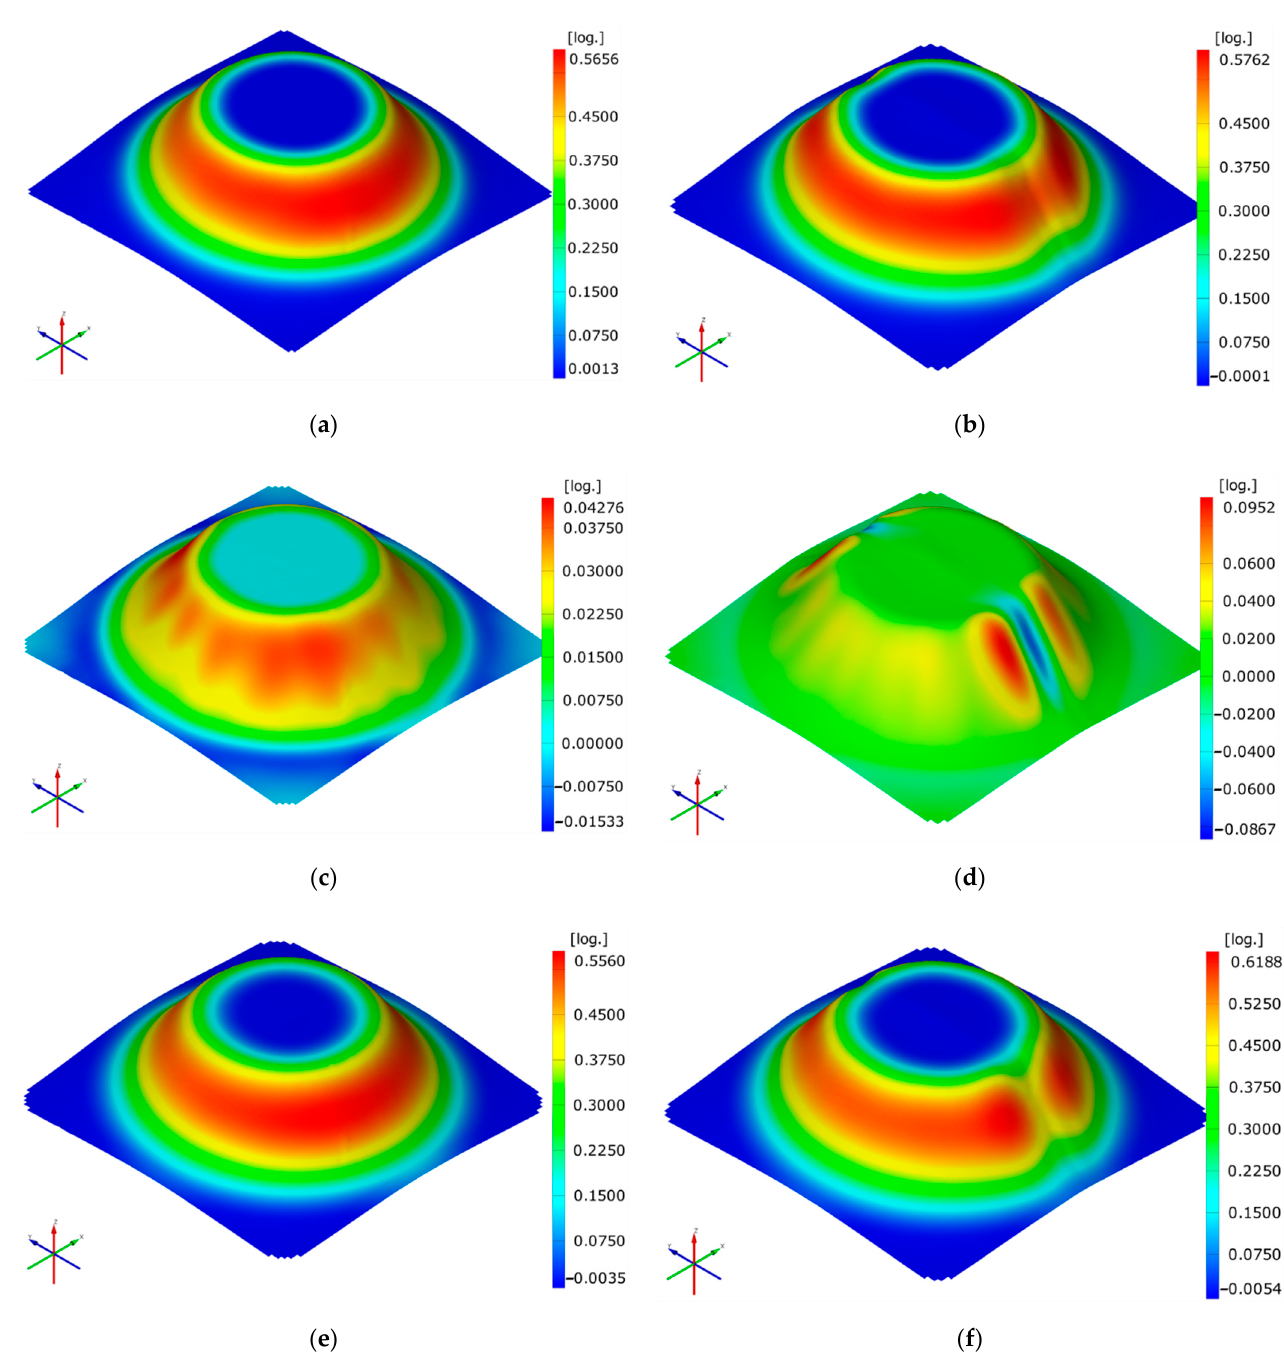
Figure 7. The major strain variation for unwelded blanks ( a ) and double side welded blanks ( b ), the minor strain variation for unwelded blanks ( c ) and double side welded blanks ( d ) and the thickness reduction variation for unwelded blanks ( e ) and double side welded blanks ( f ) for truncated cone-shaped parts.